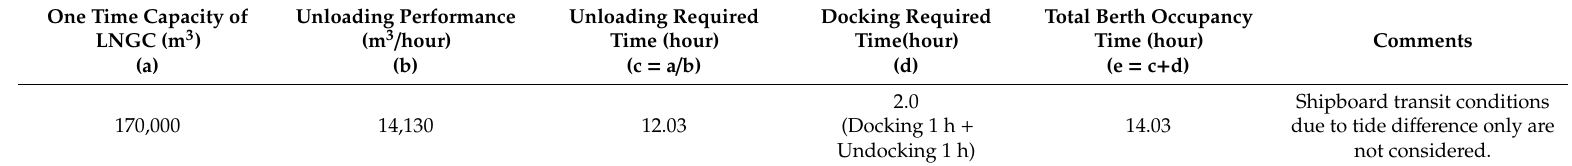
Table A8. Estimated Total Berth Occupancy Time of LNGC per One.